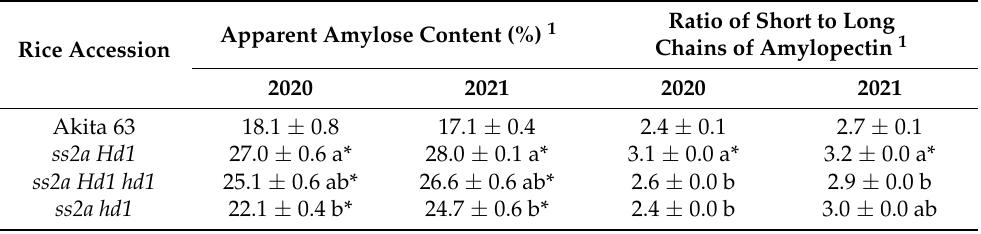
Table 2. Apparent amylose content and ratio of short to long chain of amylopectin in different rice accessions.